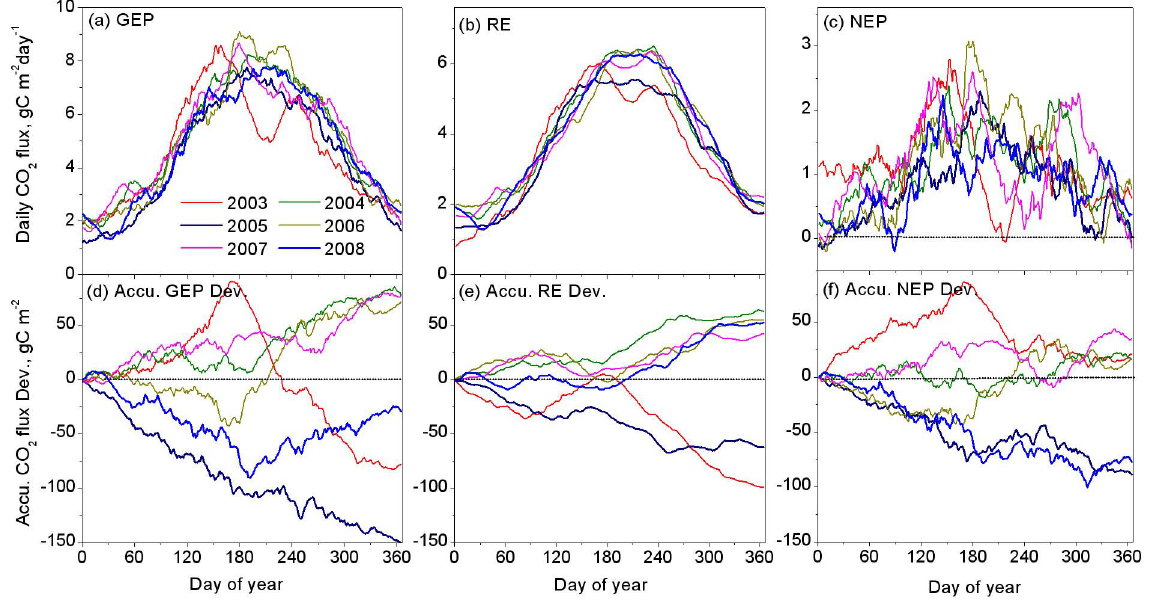
Fig. 6. The 30-day slide-averaged CO 2 fluxes (a–c) and the accumulative flux deviations (d–f) during 2003–2008. These deviation curves reflected the varying processes of CO 2 fluxes over years.